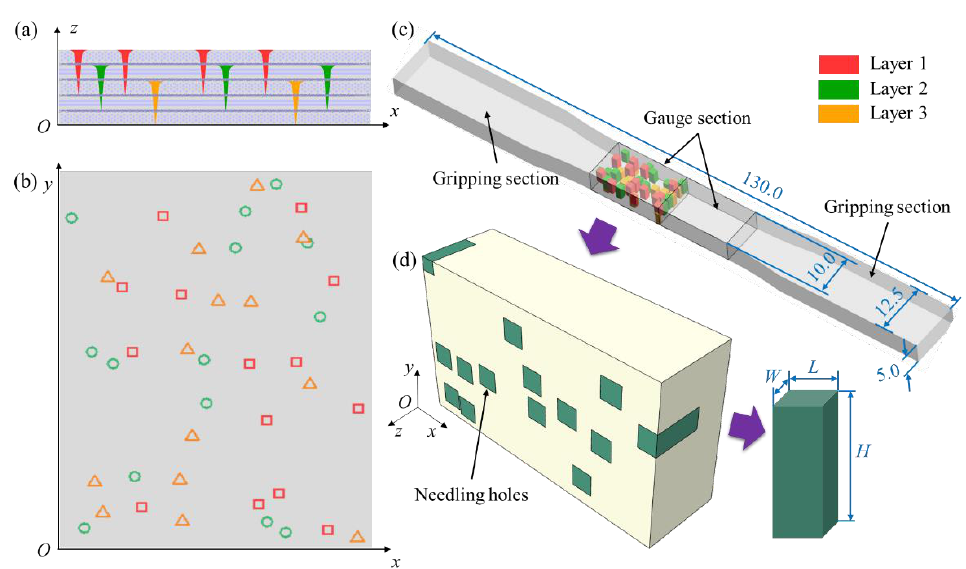
Figure 4. Schematic diagrams of ( a ) needling depth ( O − xz ) and ( b ) needling distribution ( O − xy ). ( c ) specimen size and model sampling location (unit: mm) ( d ) FE model.